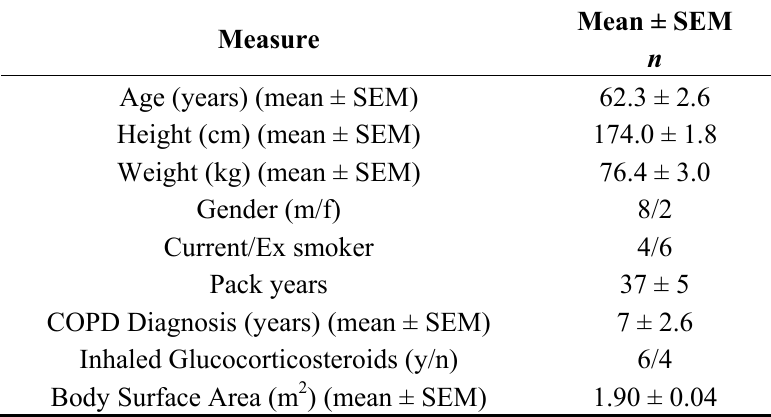
Table 1. Patient demographics.